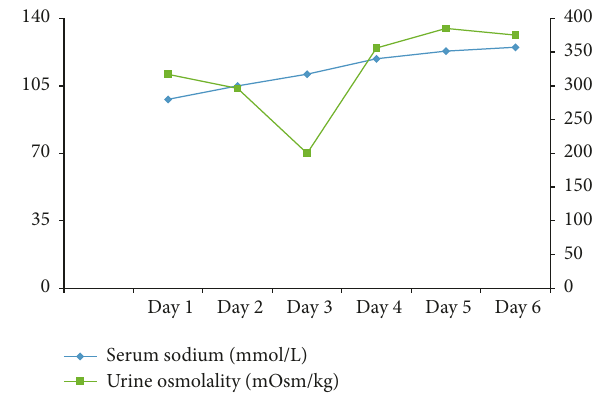
Figure 1: Daily trend of serum sodium plotted on left 𝑦 -axis and urine osmolality plotted on right 𝑦